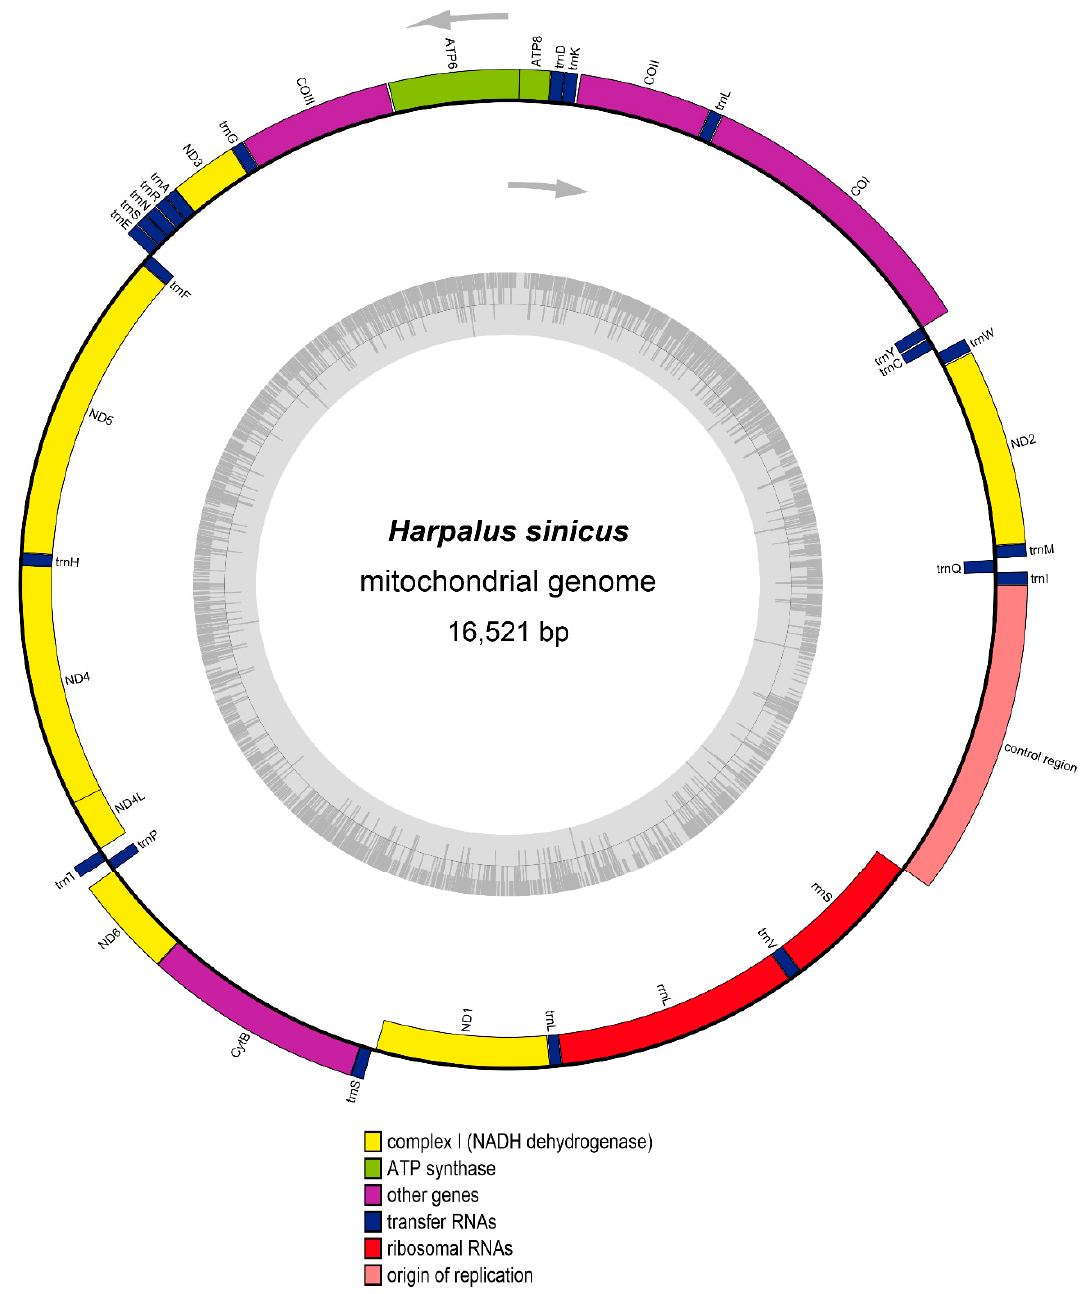
Figure 1. Gene map of the complete mitogenome of H. sinicus . Genes outside the circle are located on the J-strand, whereas those inside the circle are located on the N-strand. Table 1. Organization of H. sinicus mitogenome.